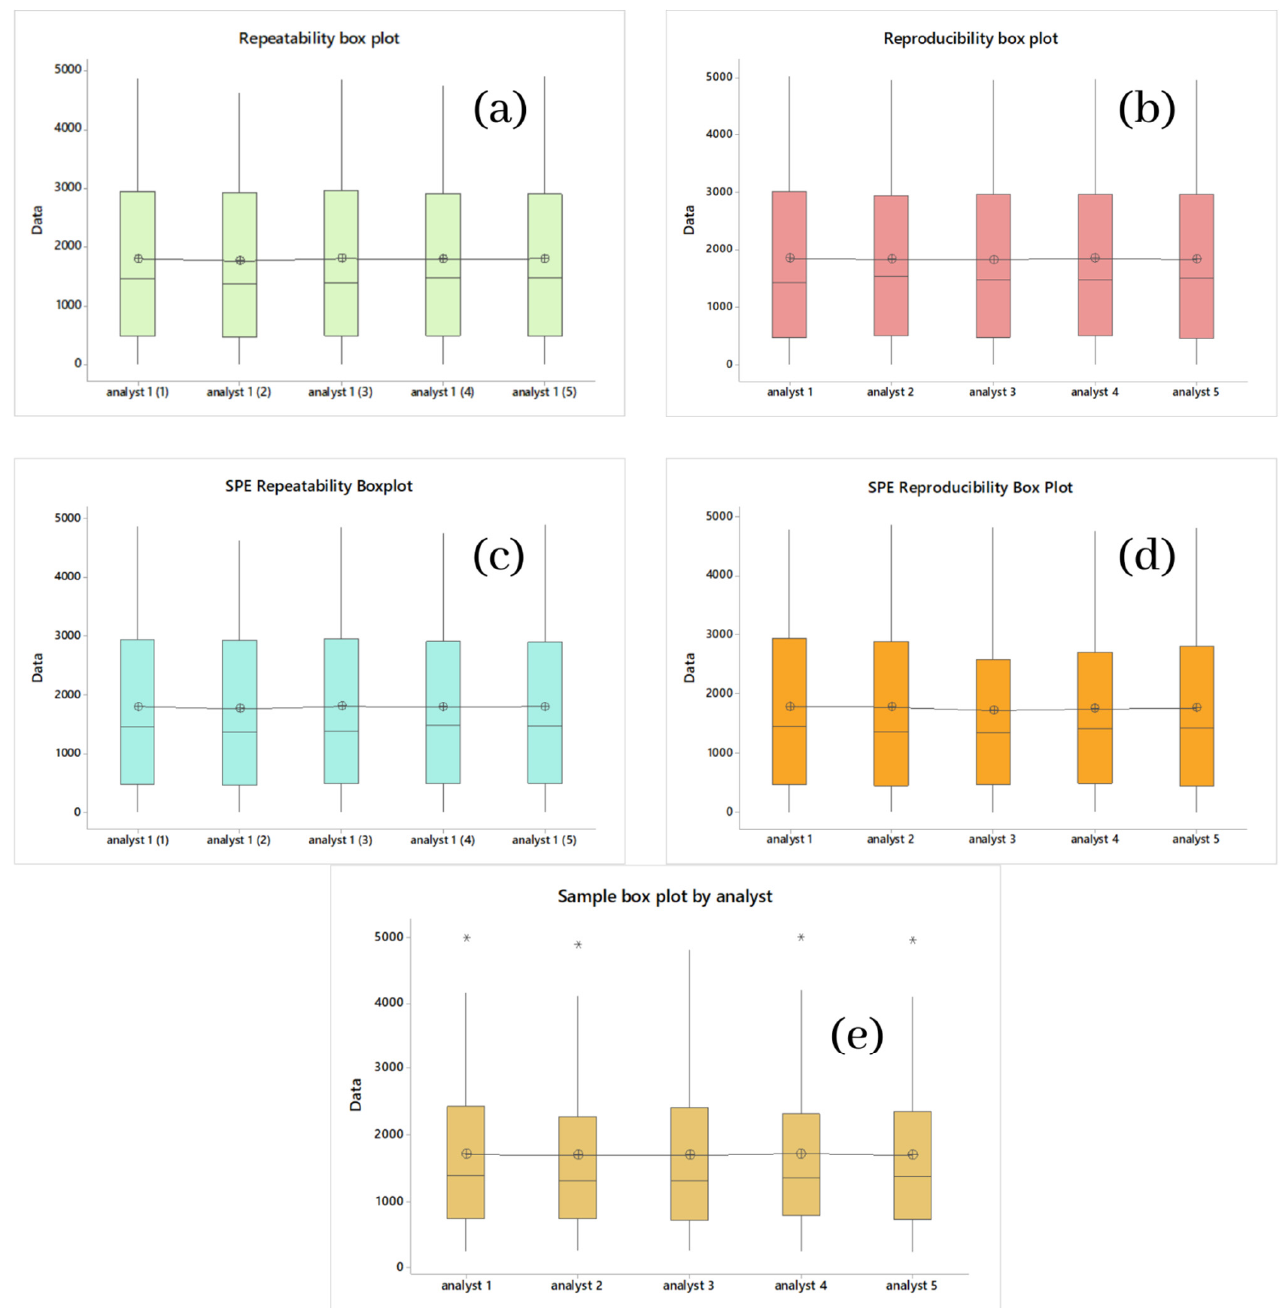
Figure 2. ( a ) Box Chart Repeatability of Banners; ( b ) Box Graph Reproducibility of Banners; ( c ) Box Graph Repeatability of Recovery of Banners; ( d ) Box Graph Reproducibility of Recovery of Banners; ( e ) Graph of Box Reproducibility of Samples. *, p ≤